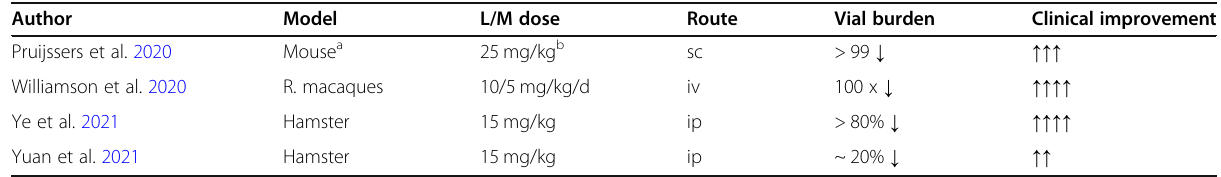
Table 5 Efficacy of remdesivir in SARS-CoV-2 animal